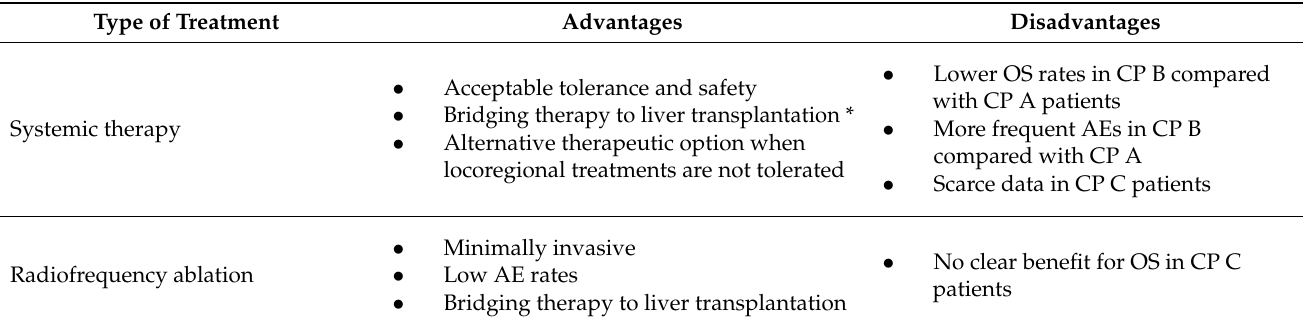
Table 4. Advantages and disadvantages per treatment category in patients with decompensated cirrhosis and hepatocellular